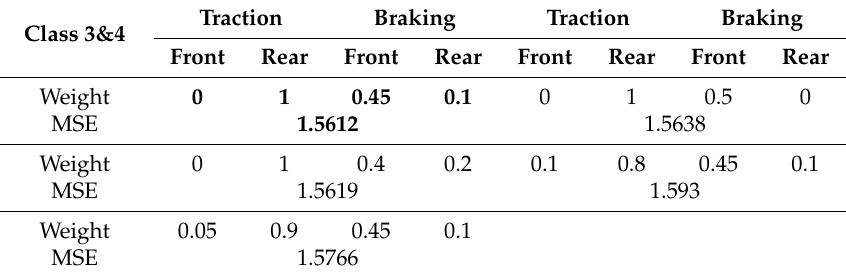
Table 8. Weight selection of Weighted Average in Class 3 and 4